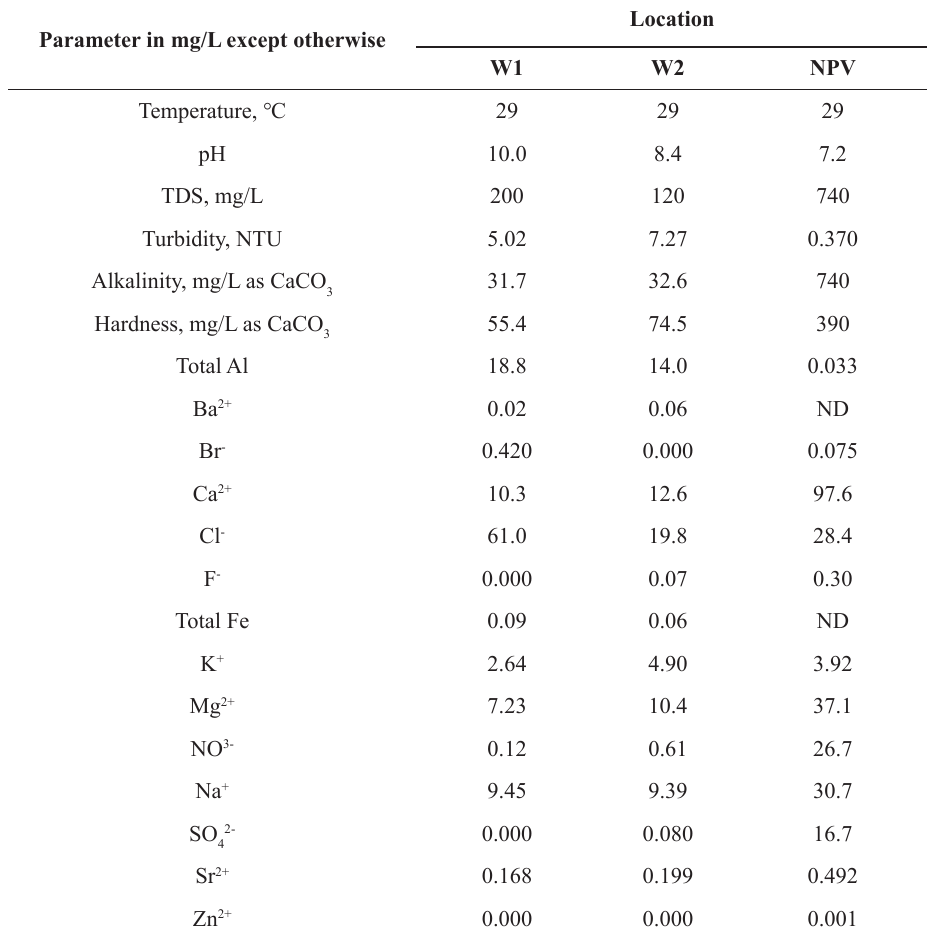
Table 1: Geochemical composition of water at recharge (W1 and W2) and discharge (NPV) points.